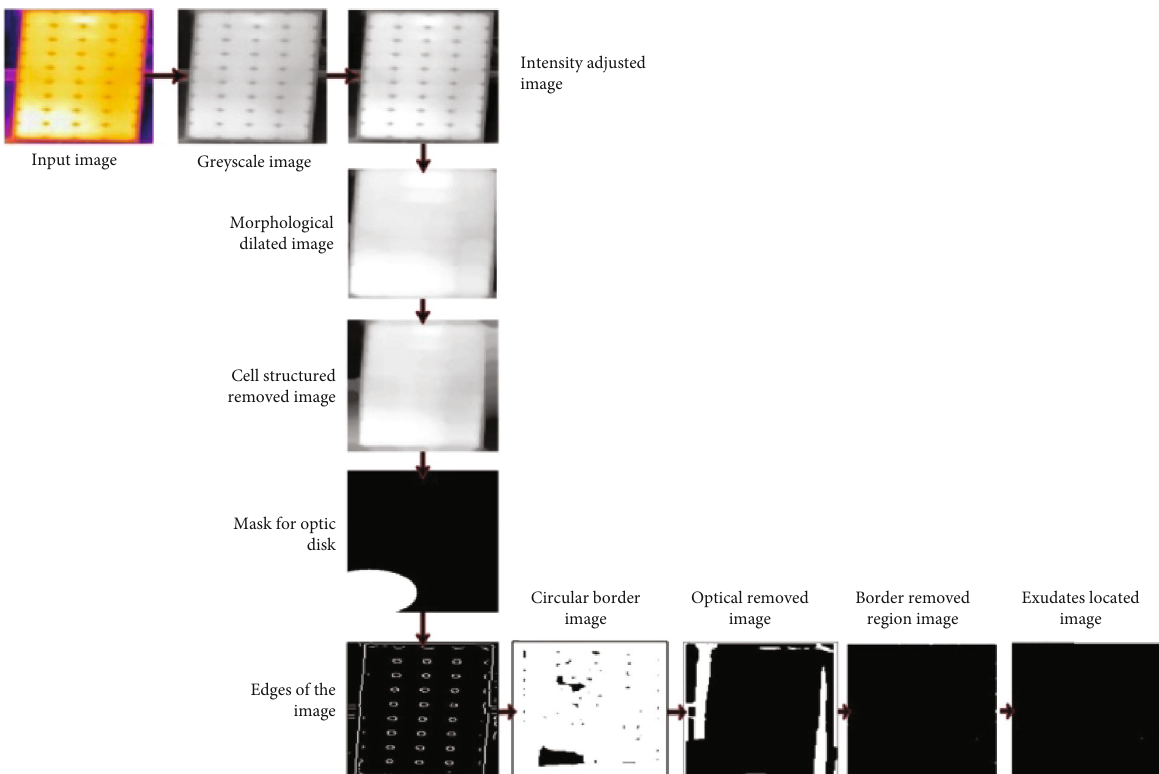
Figure 9: New solar panel thermal image